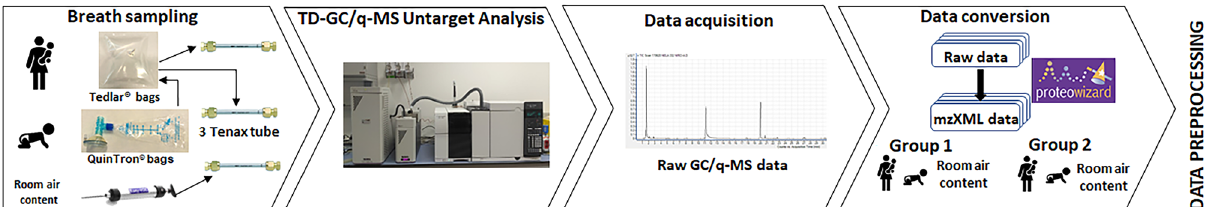
Figure 1. Steps of the biomarker discovery phase conducted before data